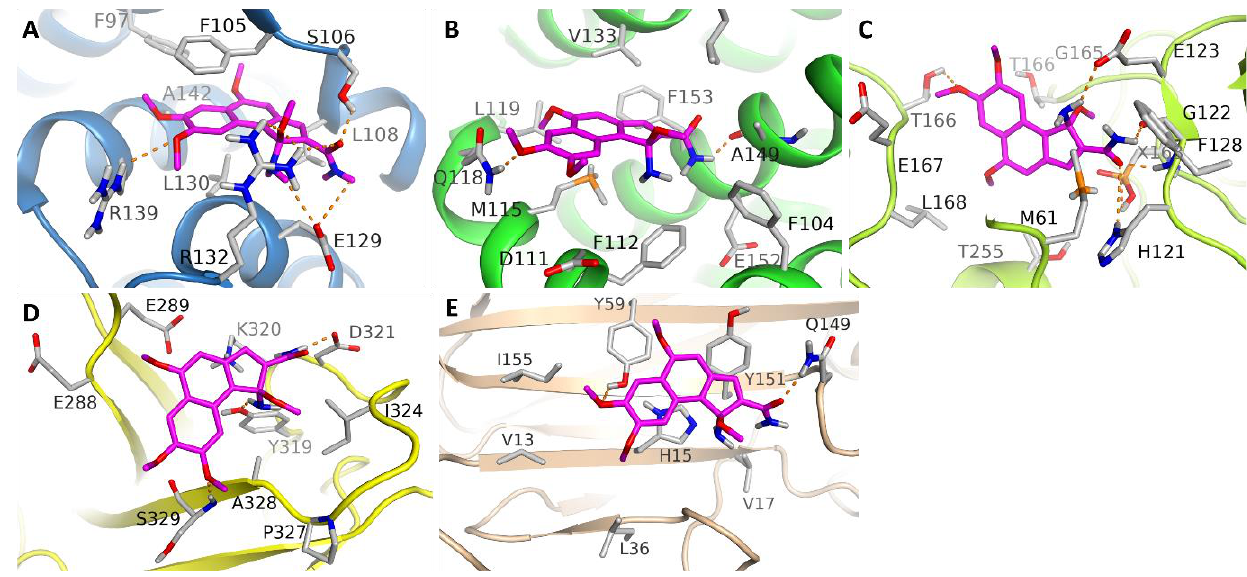
Figure 6. Top ranked docking conformations of our tested hit in selected proteins ( A ) LFD-BCL-XL, ( B ) LFD-BCL-2, ( C ) LFD-Caspases-3, ( D ) LFD-NF-kB, and ( E ) LFD-TNF- α. Predicted bonding interactions of hydrogen illustrated in dashed lines (yellow).